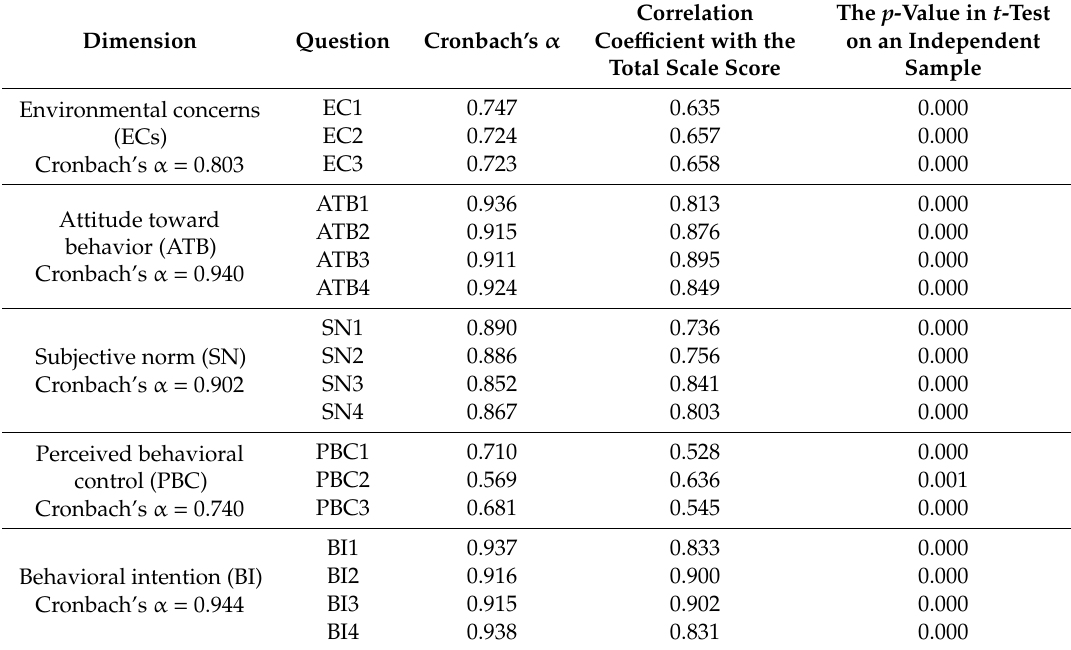
Table 3. Results of the